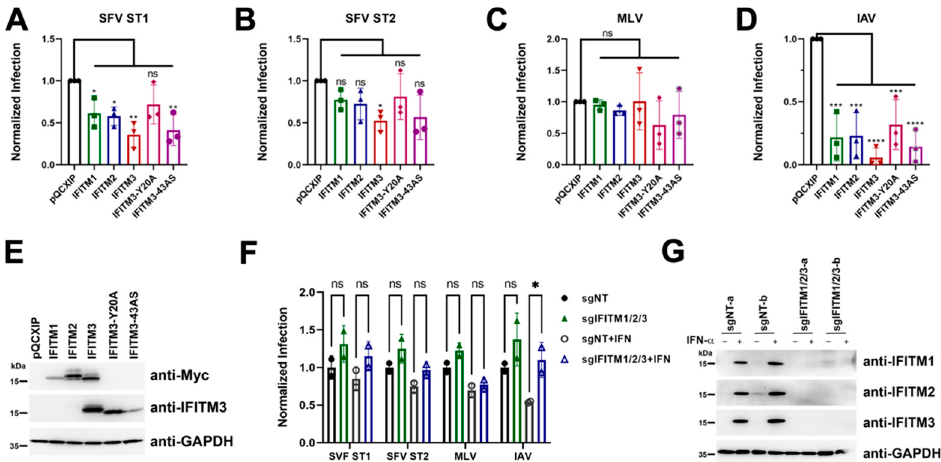
Figure 7. No evidence for env -associated differences in susceptibility to IFITM-mediated restriction. ( A–D ) A549 cells were transduced with pQCXIP-constructs to express IFITM1, IFITM2, IFITM3, IFITM3-Y20A, IFITM3-43AS or pQCXIP (empty vector). IFITM overexpressing cells were infected with SFV ST1, SFV ST2, MLV lentiviral pseudotype (MLV-LP) or IAV lentiviral pseudotype (IAV-LP). Infection was measured using flow cytometry to detect expression of the fluorescent reporter gene. The data show values normalized to pQCXIP (empty vector), and error bars represent standard error of the mean of five experiments, each performed in triplicates. Statistical significance was determined by ordinary one-way ANOVA ( p > 0.05, ns; p ≤ 0.05, *; p ≤ 0.01, **; p ≤ 0.001, ***; p ≤ 0.0001, ****). ( E ) Representative Western blot of IFITM overexpressing cells. Expression of myc-tagged IFITMs was determined using anti-myc antibody. Expression of IFITM 3 was determined using anti-IFITM3 antibody. GAPDH served as loading control. ( F ) IFITM1/2/3 triple-knockout. A549 cells were transduced with lentiviral vectors encoding Cas9 and the sgRNAs IFITM-knockout (sgIFITM1/2/3-a, sgIFITM1/2/3-b) or control cells (sgNT-a, sgNT-b) treated with IFN- α (5000 U/mL) or H 2 O (control) and infected with SFV ST1, SFV ST2, MLV lentiviral pseudotype (MLV-LP) or IAV lentiviral pseudotype (IAV-LP). Infection was measured using flow cytometry to detect expression of the fluorescent reporter gene. The data show values normalized to the average of sgNT-a, sgNT-b and error bars represent standard error of the mean of five experiments, each performed in triplicates. Statistical significance was determined by 2-way ANOVA ( p > 0.05, ns; p ≤ 0.05, *). ( G ) Representative Western blot of control (sgNT-a or sgNT-b) cells or IFITM knockout (sgIFITM1/2/3-a or sgIFITM1/2/3-b) treated with or without IFN- α (5000 U/mL). IFITM expression was detected with anti-IFITM1, anti-IFITM2 or anti-IFITM3; GAPDH served as loading control.